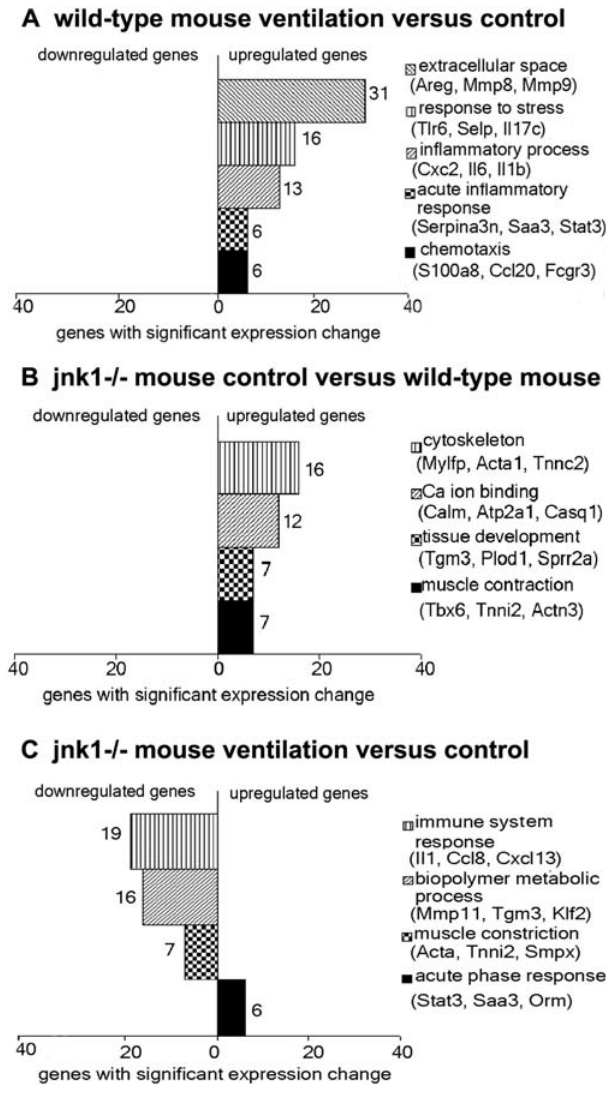
Figure 7. Gene Ontology analysis. Gene expression ratios were analyzed under the following conditions: (A) wild-type mouse ventilation versus control (total genes: 335), (B) jnk1 2 / 2 mouse control versus wild-type mouse control (total genes: 314), and (C) jnk1 2 / 2 mouse ventilation versus control (total genes: 686). Values represent gene numbers enriched in a functional annotation. Functional groups of upregulated genes are shown on the right side of the panel and groups of downregulated genes are shown on the left side of the panel. Gene symbols and names: amphiregulin (Areg), matrix metalloprotei- nase-8 and 9 (Mmp8, Mmp9), toll-like receptor 6 (Tlr6), p-selectin (Selp), interleukin 17C (Il17c), chemokine ligand 2 (Cxcl2), interleukin 6 and 1b (Il6, Il1b), serine protease 3 (serpina3), serum amyloid A3 (Saa3), signal transducer and activator of transcription 3 (Stat3), calgranulin A (S100a8), chemokine ligand 20 (Ccl20), IgG Fc receptor (Fcgr3), myosin-light chain (Myflp), alpha1 actin (Acta1), troponin C2 (Tnnc2), calmodulin (Calm), atpase 2A1 (Atp2a1), calsequestrin 1 (Casq1), transglutaminase 3 (Tgm3), lysine hydroxylase 1 (Plod1), small proline- rich protein 2A (Sprr2a), t-box 6 (Tbx6), troponin I2 (Tnni2), alpha3 actinin (Actn3), interleukin 1 (Il1), monocyte chemotactic protein 2 (Ccl8), chemokine receptor 13 (Cxcl13), eg. matrix metalloproteinase 11 (Mmp11), kruppel-like factor 2 (Klf2),alpha actin (Acta), troponin I2 (Tnni2), small muscle protein (Smpx), orosomucoid